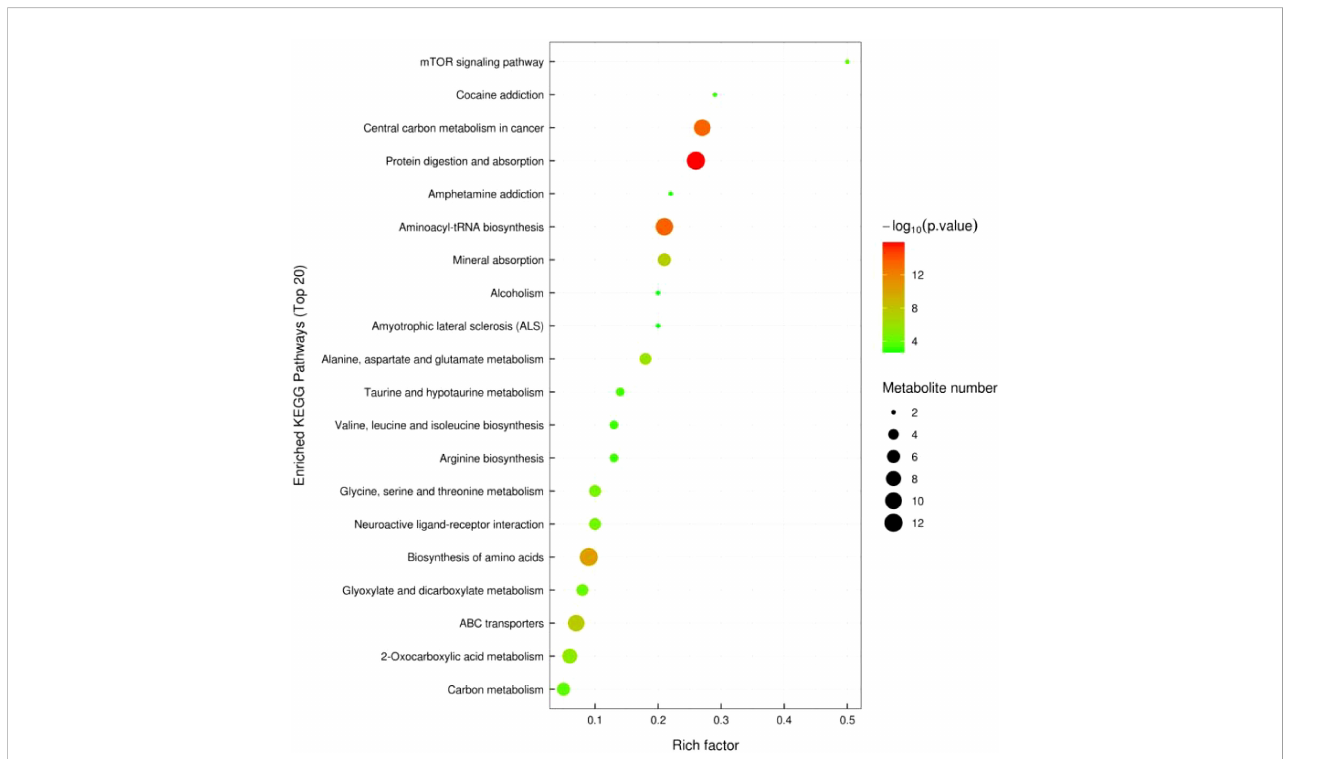
FIGURE 10 KEGG Enriched Pathway Diagram for Placebo vs. Normal Young Group (Bubble Diagram).